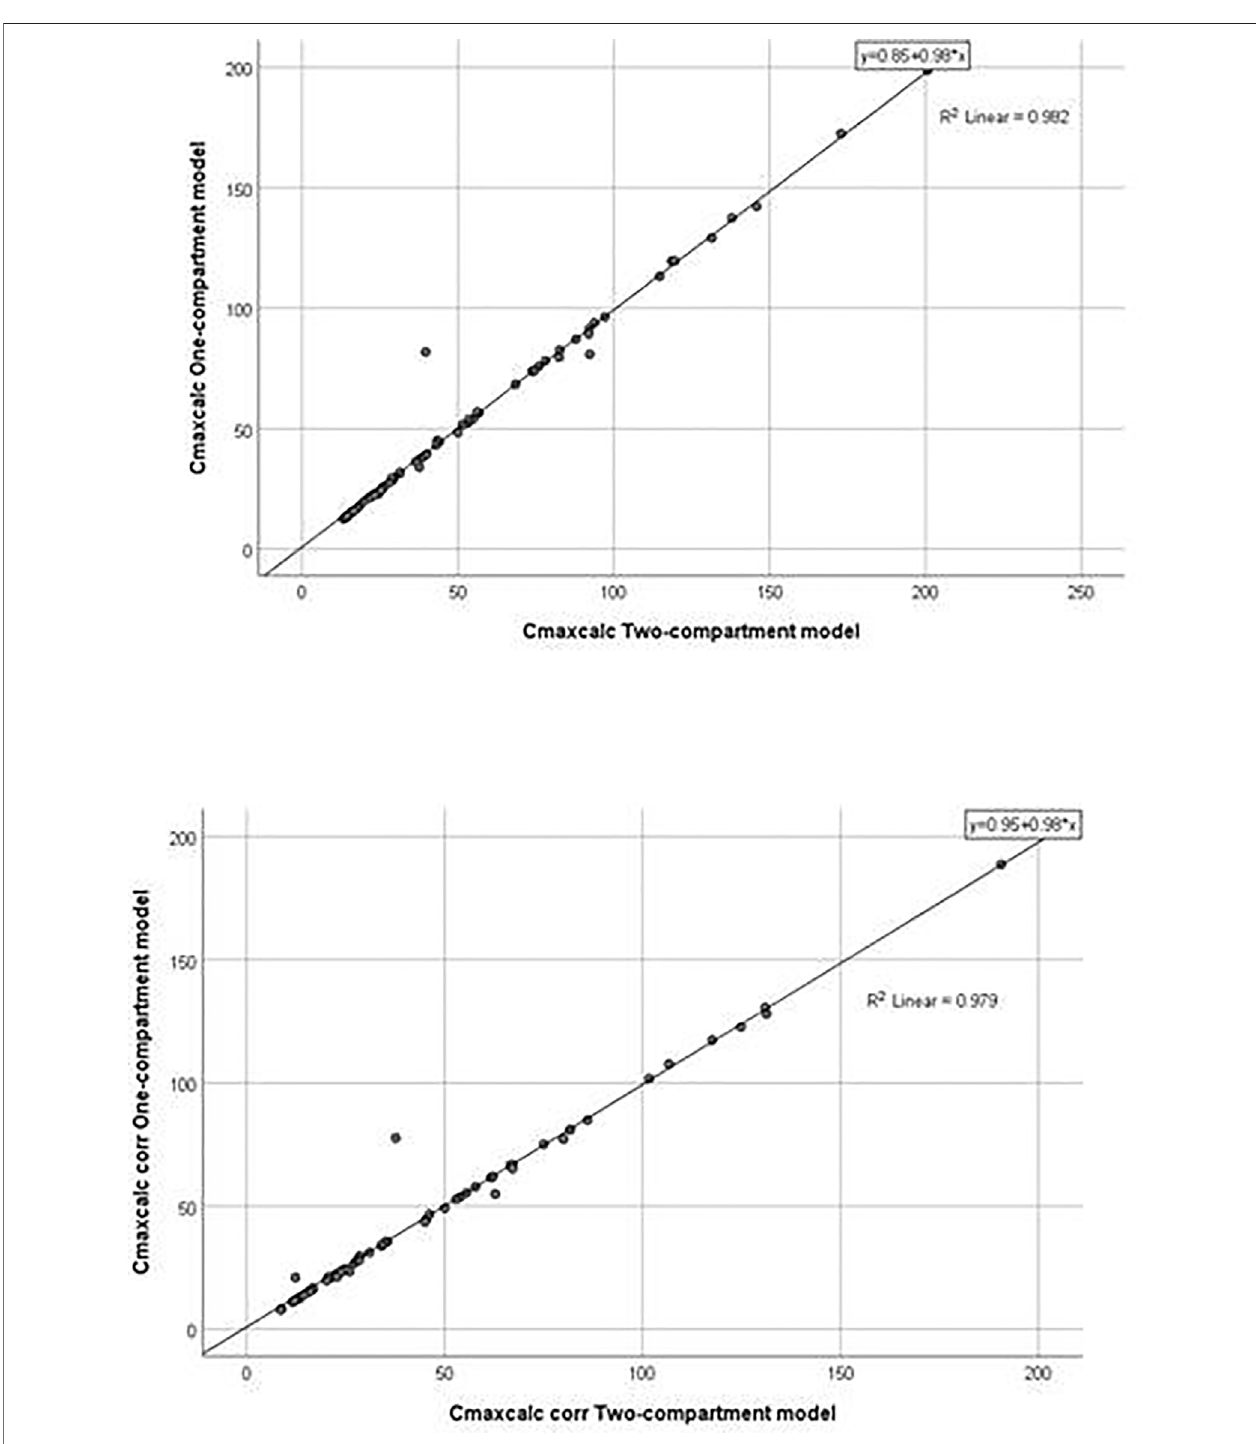
FIGURE 6 | Goodness-of- fi t plots for the one-compartment model versus the two-compartment model (C maxcalc and C maxcalc corr ).